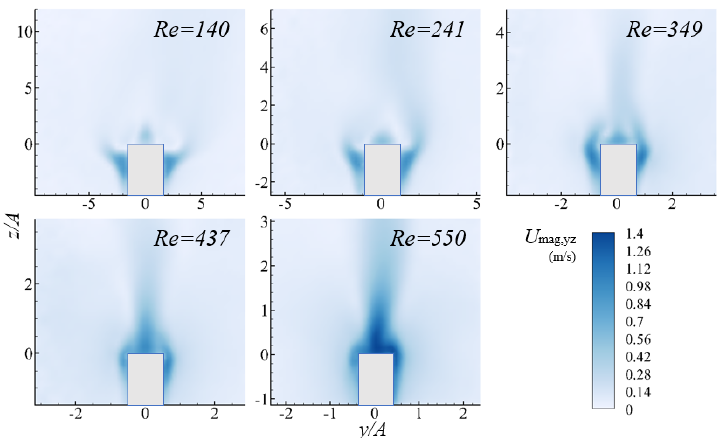
Figure 4. Time-averaged velocity magnitude ( U mag,yz ) field of the y - z plane at different Reynolds numbers.